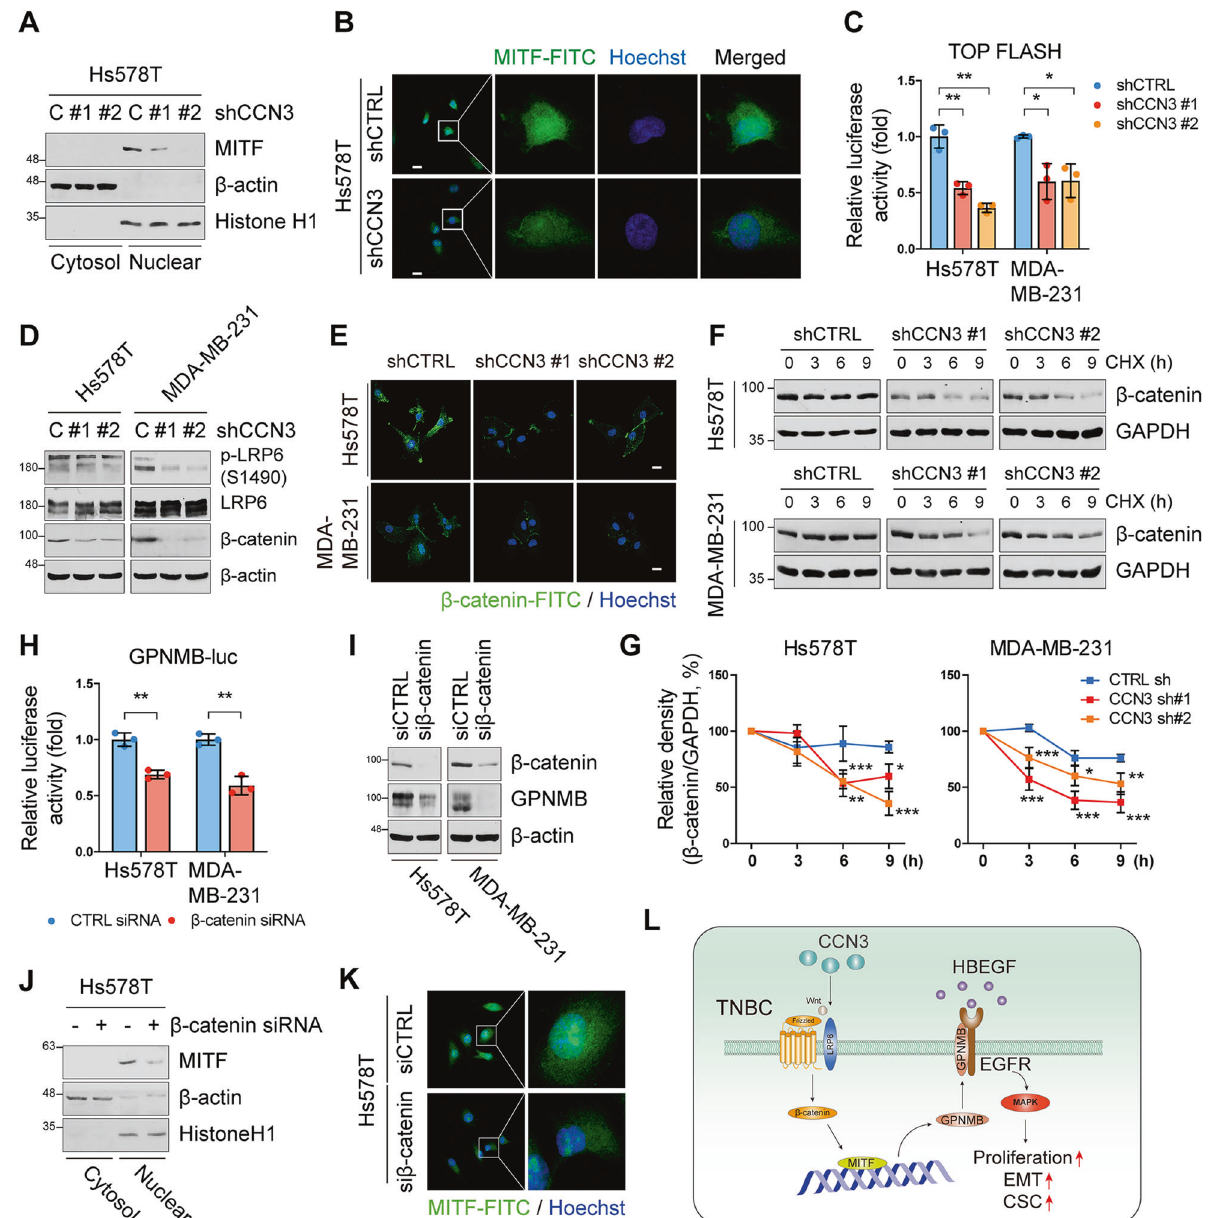
Fig. 8 CCN3 regulates GPNMB expression by Wnt signaling induced MITF activation. A Western blot analysis of lysate isolated into cytoplasm and nuclear fraction of CCN3 knockdown cell line using the indicated antibodies. β -actin and histone H1 were used as a loading control for cytosol and nuclear fraction, respectively. B Immuno fl uorescence assay performed with indicated antibodies (scale bar = 20 μ m). C Dual luciferase assay was performed using pSUPER-TOP FLASH construct. pCMV-RL was used as an internal control. Mean ± SD ( n = 3). P -values were calculated with one-way ANOVA with a post-hoc Dunnett ’ s multiple comparison test (* p < 0.05, *** p < 0.0005). D , E Western blot ( D ) and immuno fl uorescence ( E ) analysis with indicated antibody showed decreased Wnt/ β -catenin signaling proteins in Hs578T and MDA- MB-231 CCN3 knockdown cell lines (scale bar = 20 μ m). F , G Cyclohexamide (CHX) chase assays were performed for measuring β -catenin degradation in Hs578T and MDA-MB-231 CCN3 knockdown cell lines. Each cell line treated with CHX (100 μ g/ml) at the indicated time points. Quanti fi cation of western blot band was performed using ImageJ software. Mean ± SD ( n = 3). P -values were calculated with two-way ANOVA with a Bonferroni posttest (* p < 0.05, ** p < 0.005, *** p < 0.0005). H Western blot analysis of whole cell lysate with indicated antibody. Hs578T and MDA-MB-231 were treated with β -catenin siRNA for 48 h. β -actin was used as a loading control. I Dual luciferase assay was performed using a pGL3-GPNMB-luc construct. pCMV-RL was used as an internal control. Mean ± SD ( n = 3). P -value was calculated using the two-tailed student t -test (** p < 0.005). J Western blot analysis of lysate isolated into cytoplasm and nuclear of β -catenin siRNA treated Hs578T cell line using the indicated antibodies. β -actin and histone H1 were used as a loading control for cytosol and nuclear fraction, respectively. K Immuno fl uorescence assay performed with indicated antibodies (scale bar = 20 μ m). L Schematic description of CCN3 induced signaling cascade in TNBC.